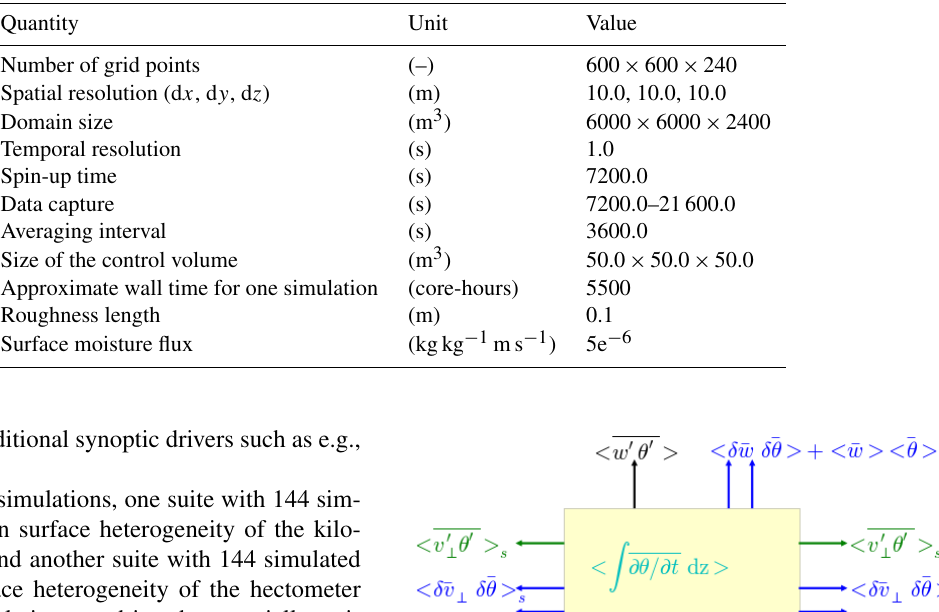
Table 1. Parameters of the LES configuration.